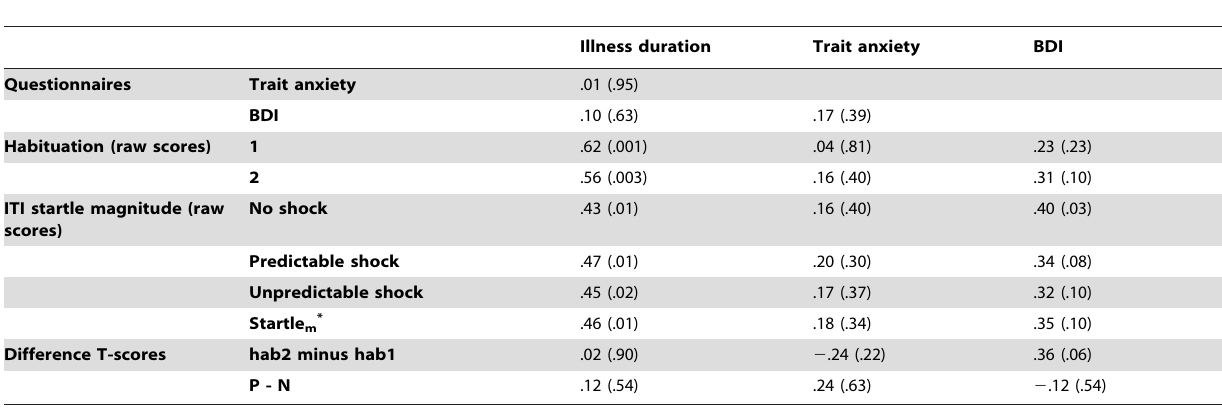
Table 1. Correlation (probability) between illness duration, trait anxiety, and BDI, and startle reactivity in the MDD patients.